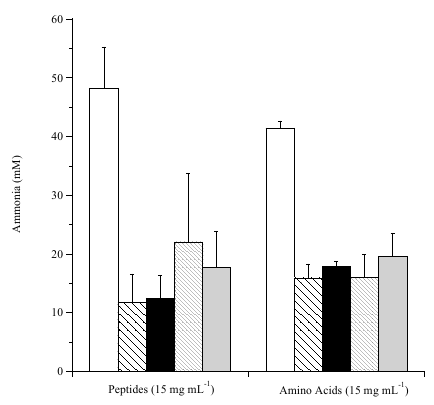
Figure 3. Ammonia production by rumen microorganisms. Washed cell suspensions of uncultivated rumen microorganisms were incubated in basal medium with either Trypticase (peptides) or Casamino acids (amino acids). The ammonia concentrations after 24 h incubation (39 °C) are shown. Black and grey bars indicate added Galena and Chinook hops, respectively. Three concentrations of each hop were used; open bars indicate no hops. hatched bars indicate 0.6 mg mL − 1 , solid bars indicate 1.2 mg mL − 1 (black hatched, Galena 0.6 mg mL − 1 ; black solid, Galena 1.2 mg mL − 1 ; grey hatched, Chinook 0.6 mg mL − 1 ; grey solid, Chinook 1.2 mg mL − 1 ). Means are shown, and error bars represent standard deviations. Ammonia production values from peptides and amino acids were not different ( p = 0.85). Hops addition significantly decreased ammonia compared to the no hops controls in all cases ( p < 0.05).